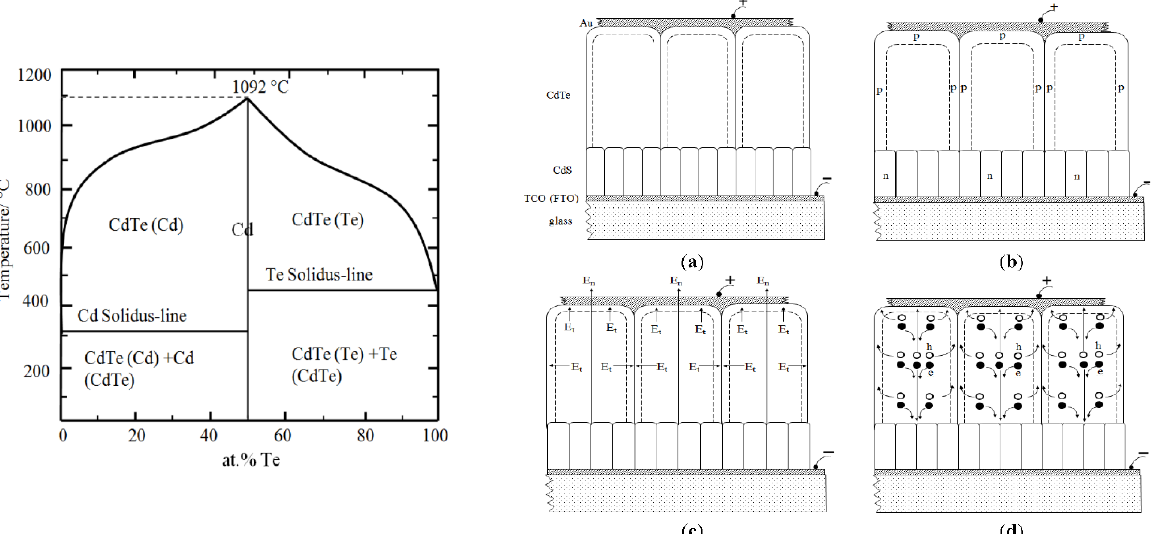
Figure 9. Phase diagram of CdTe [35] and schematic diagram of ( a ) columnar-type CdS/CdTe solar cells; ( b ) doping effects of grains after CdCl 2 treatment; ( c ) presence of local electric fields (E t ) in addition to the main electric field (E n ) within the device, and ( d ) photo-generated charge carrier separation and collection with high current densities along grain boundaries [8].